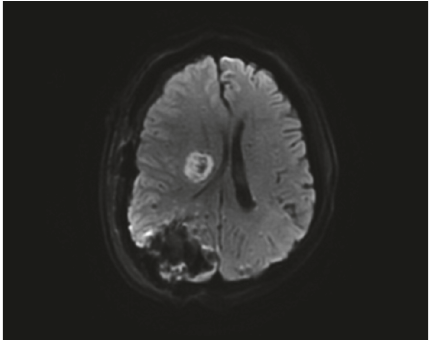
Figure 4: Noncontrast head CT performed on the 7th day demon- strates an acute hemorrhage in the right occipital lobe, with surrounding oedema and compressing the right lateral ventricle with midline shift to left.